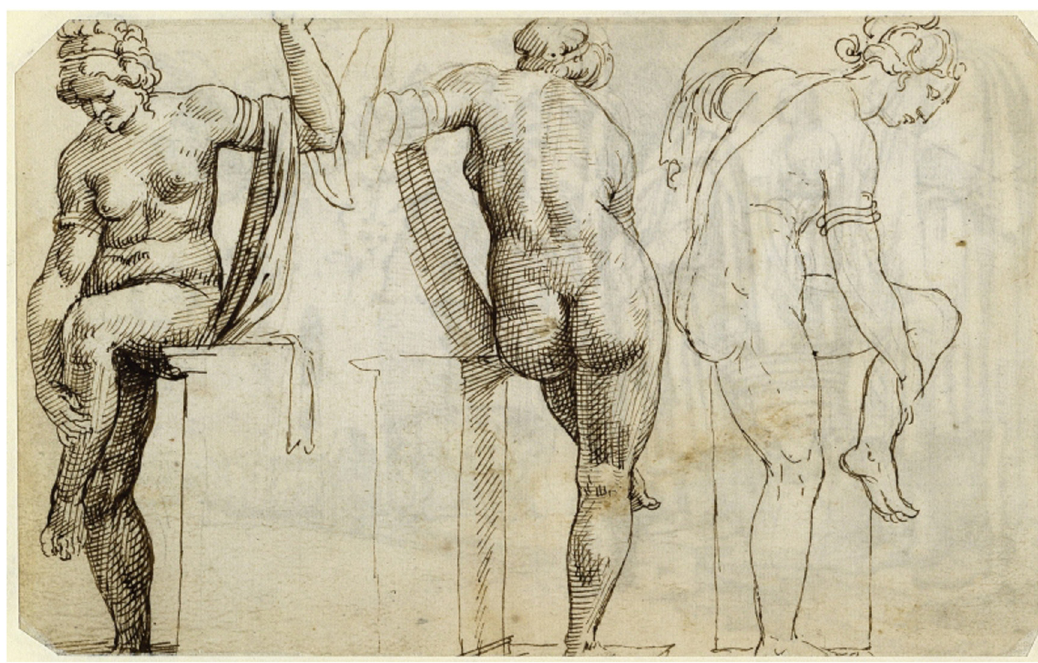
Figure 2: Multiple views of the “ Bathing Venus ” by Maarten van Heemskerk, ca. 1532 – 1536, ink on paper. Courtesy of the Kupferstichkabinett, Staatliche Museen zu Berlin/Jörg P. Anders [ CC BY - NC - SA ]